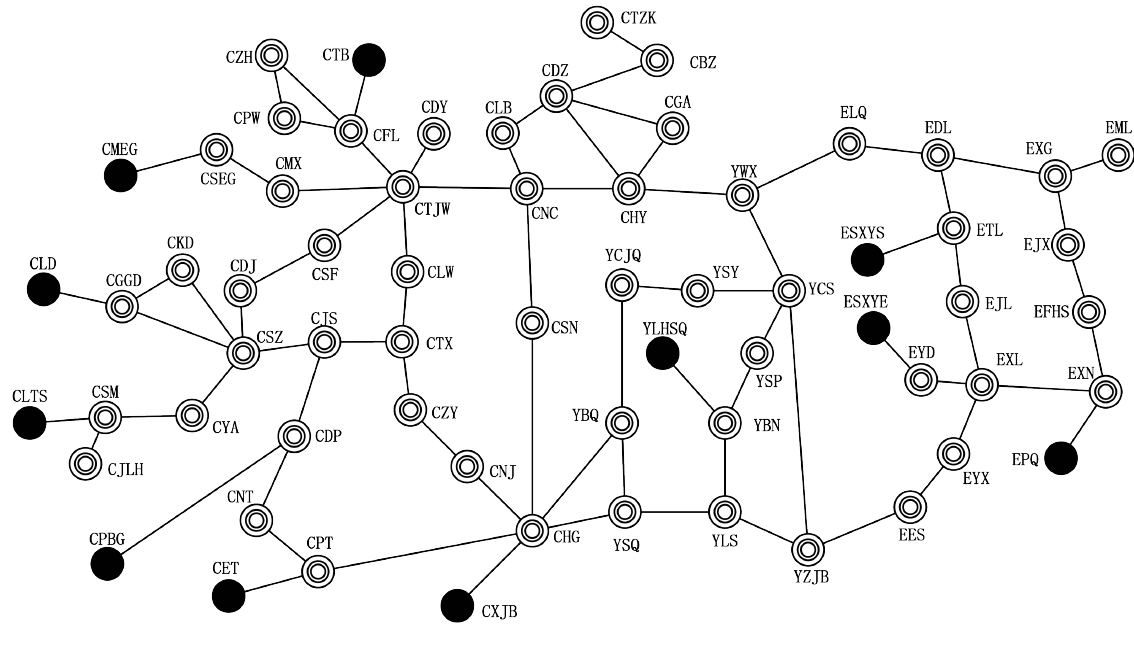
Figure 20. The reduced power system of Central China.